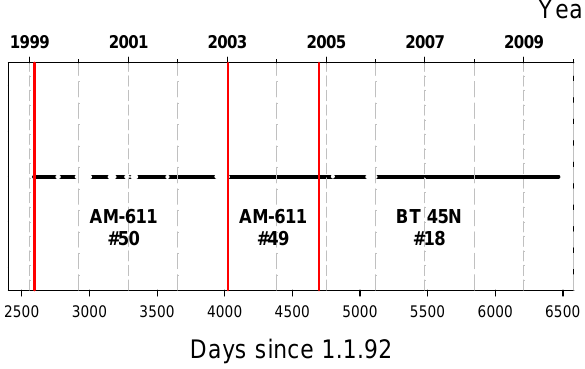
Figure 2: Overview of the span of the recorded data and the implementation of Fig. 2. Overview of the span of the recorded data and the imple- the different sensors mentation of the different sensors.